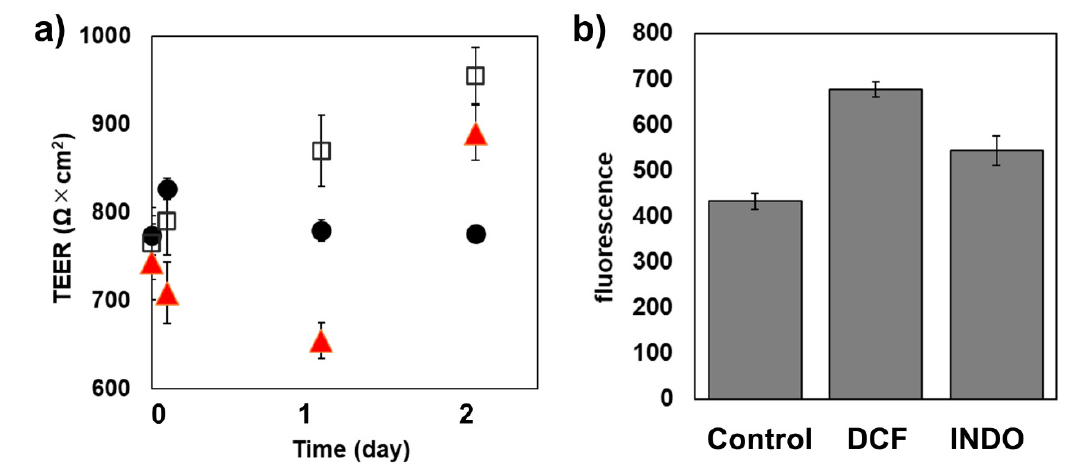
Figure 6. Effects of DCF and INDO on transepithelial electrical resistance (TEER) changes and paracellular efflux of fluorescence-labeled insulin of Caco-2 cell monolayers. ( a ) TEER changes. Filled circle, control (0.3% DMSO); red triangle, 300 µM DCF; open square, 300 µM INDO, ( b ) paracellular efflux of FITC-insulin. Cells were treated with NSAIDs (DCF or INDO) at a concentration of 300 µM for 48 h. The cells treated with 0.3% DMSO were set as a control. Error bars indicate standard deviations.